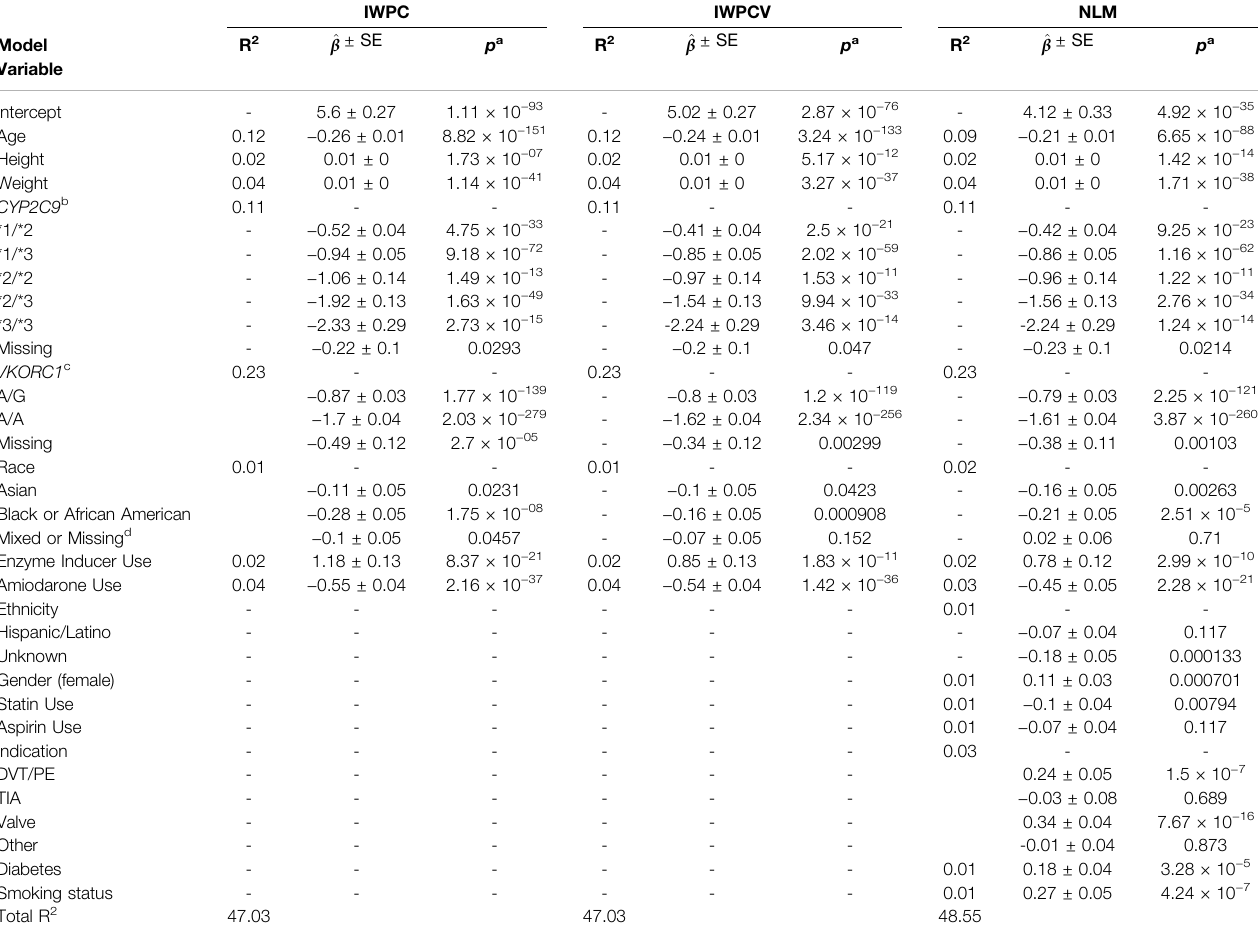
TABLE 4 | Partial R 2 values, parameter estimates with standard errors, and p -values of the 50th replicate of models trained in the Merged cohort ( n (cid:1) 7,030). IWPC